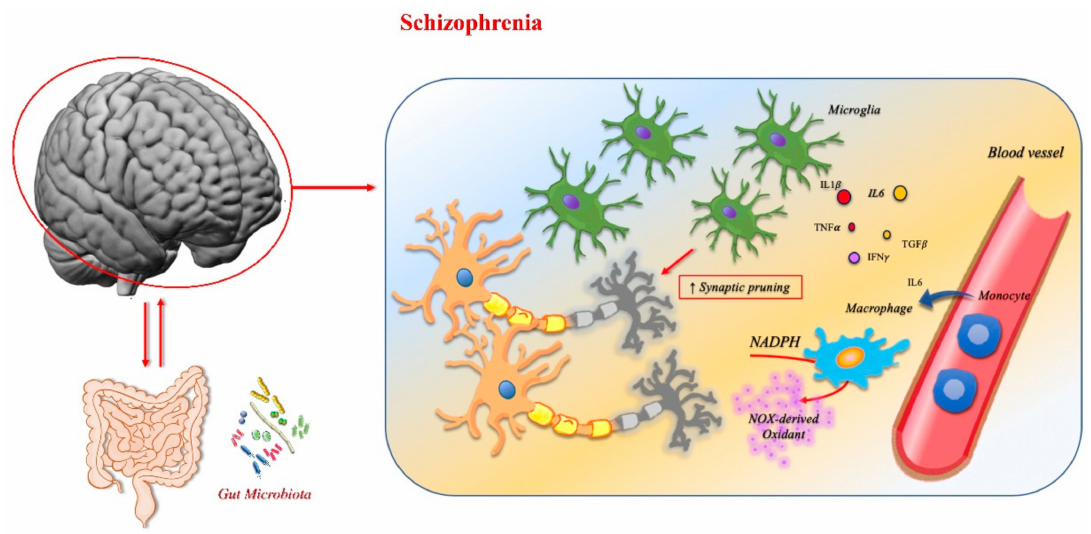
Figure 7. Schematic representation of the immunological mechanisms associated with